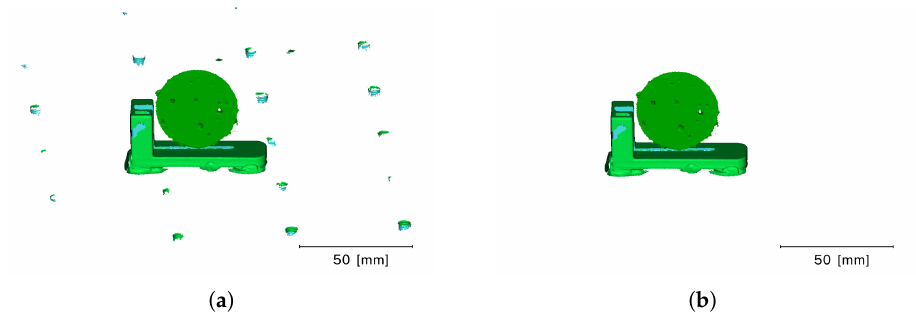
Figure 6. Model of slice no. 7 before ( a ) and after ( b ) removing unnecessary